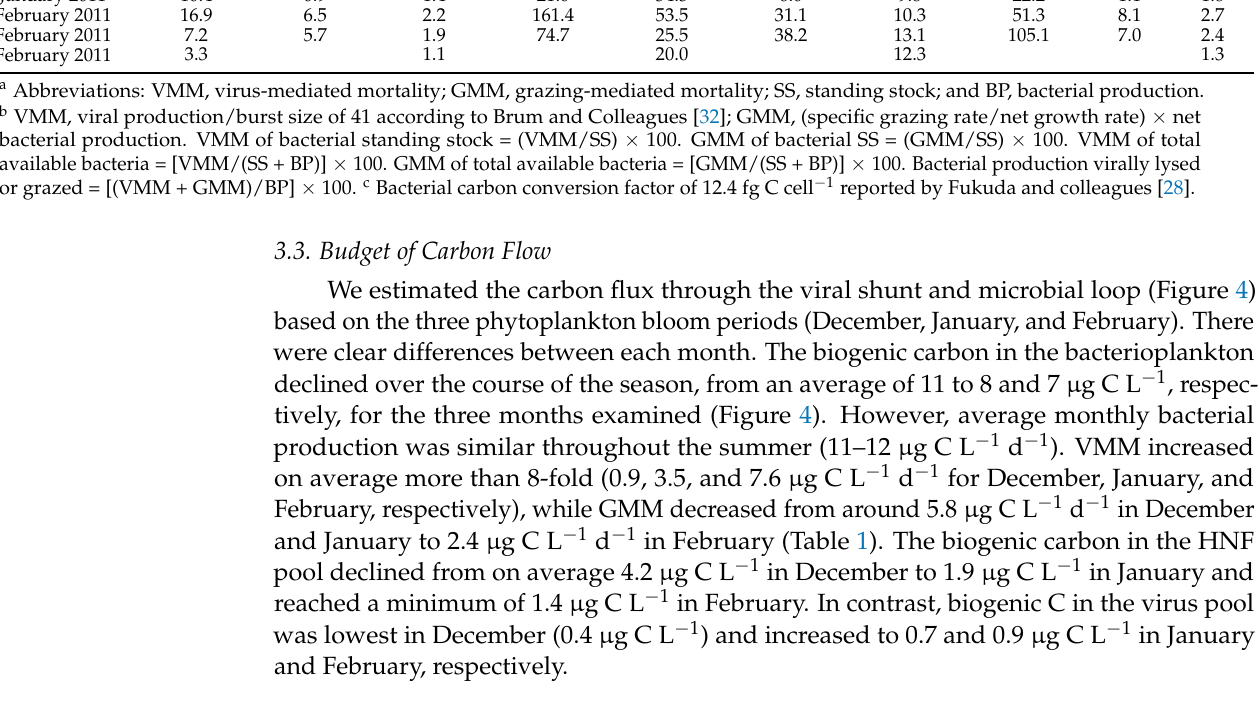
Table 1. Bacterial production and the loss of bacteria to viral and grazing-mediated mortality and their effects on carbon. Bacterial Produc- Date